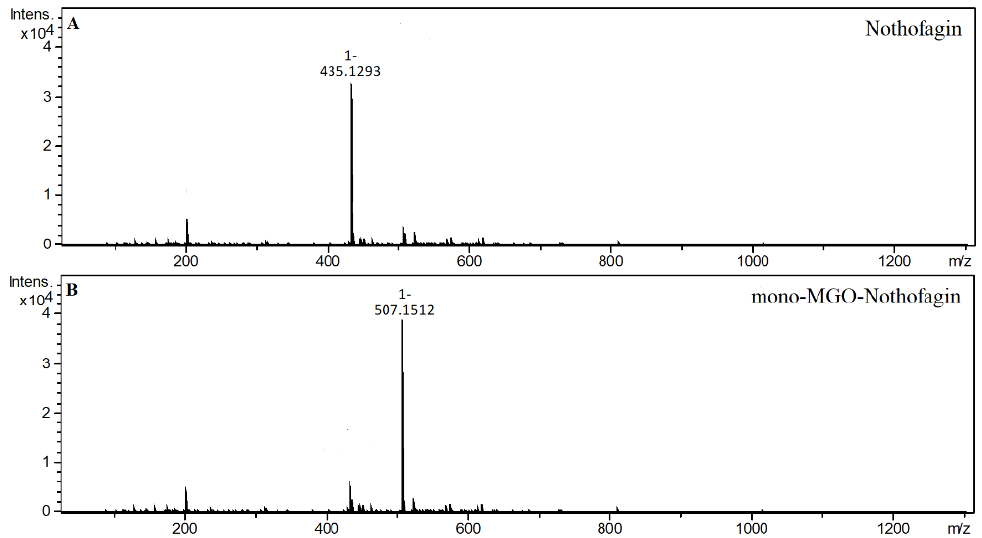
Figure 7. Mass spectra of nothofagin and its methylglyoxal adduct after 1 h of incubation in pH 7.4 phosphate buffer solution at 37 °C; ( A ), nothofagin; ( B ), mono-MGO-nothofagin.